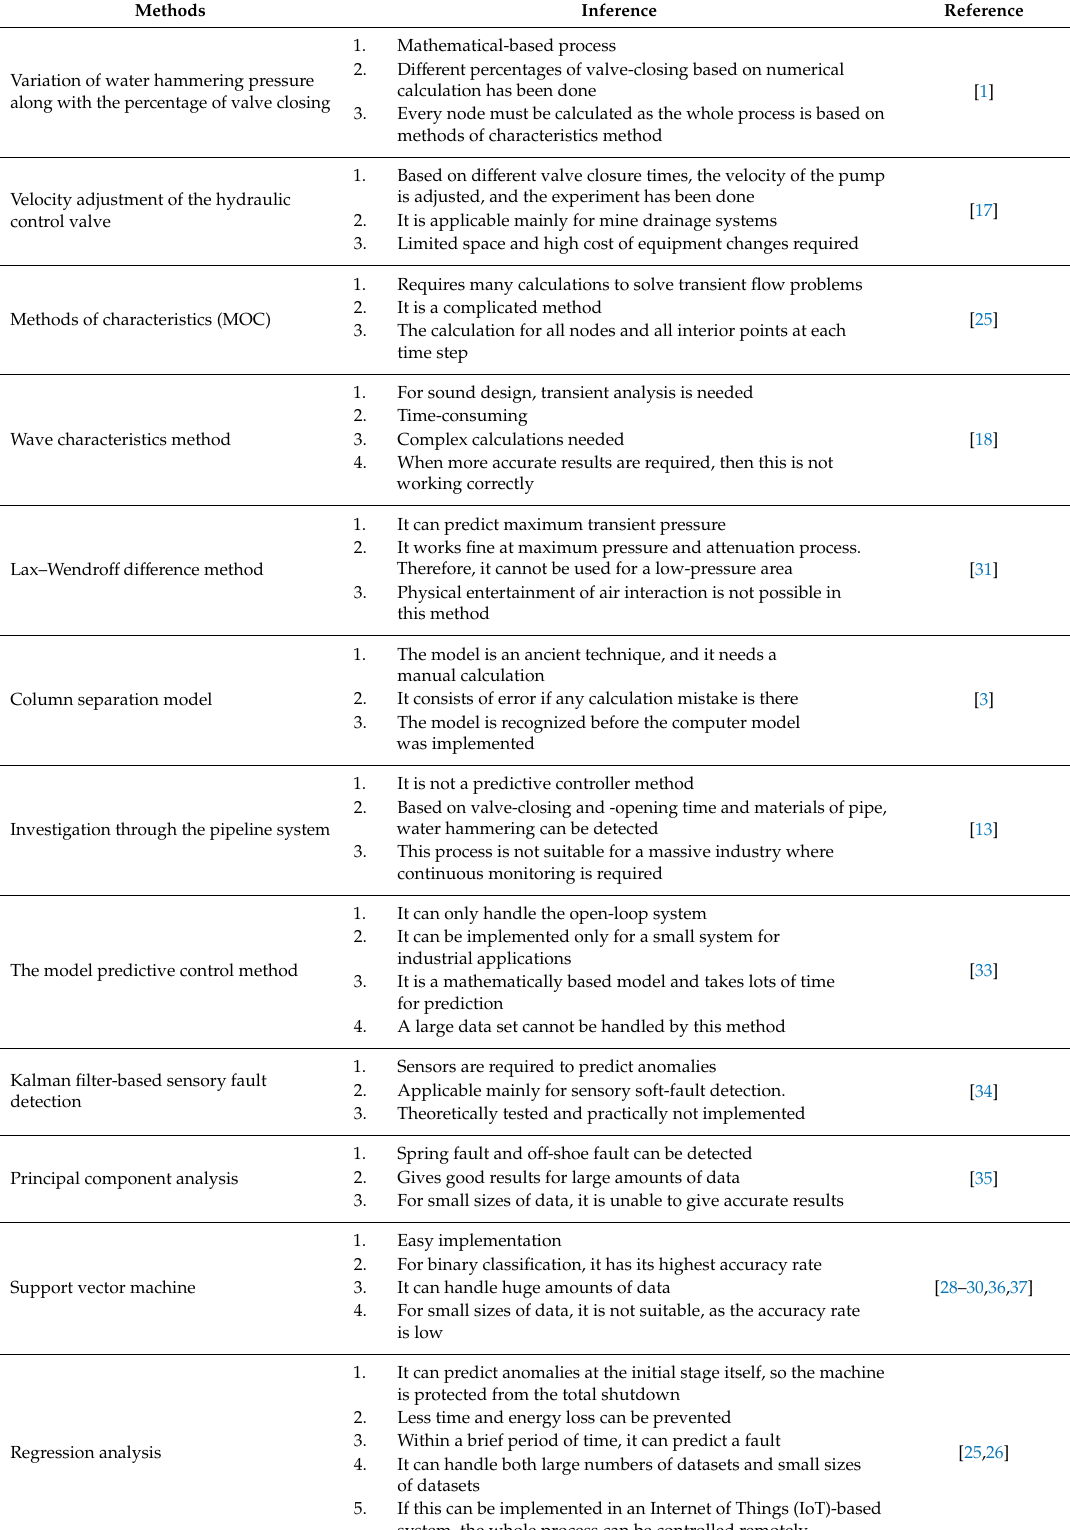
Table 6. Comparison among conventional methods, previously proposed predictive control methods and machine-learning-based methods for water hammering